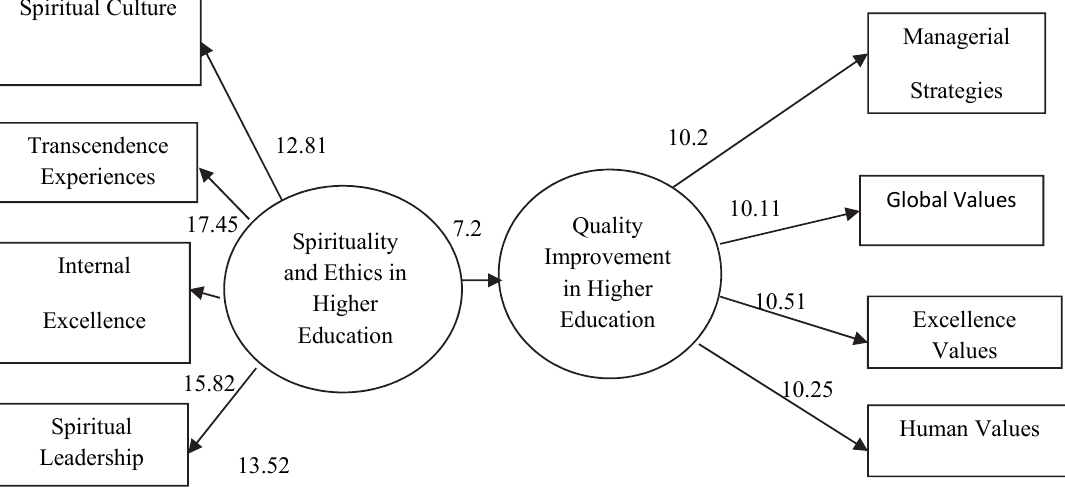
Fig. 10. t value Model: Spirituality and Ethics have positive effects on Quality